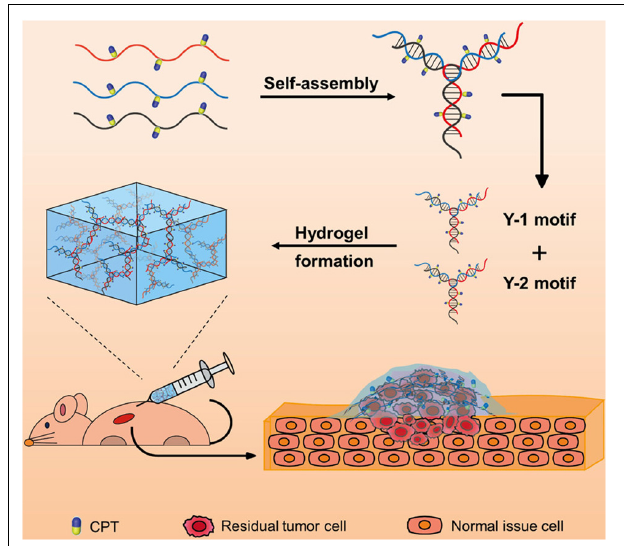
FIGURE 6 | Schematic diagram of the injectable drug-conjugated DNA hydrogel for local chemotherapy to prevent tumor recurrence. Reprinted with permission from Zhang et al. (2020). Copyright (2020) American Chemical